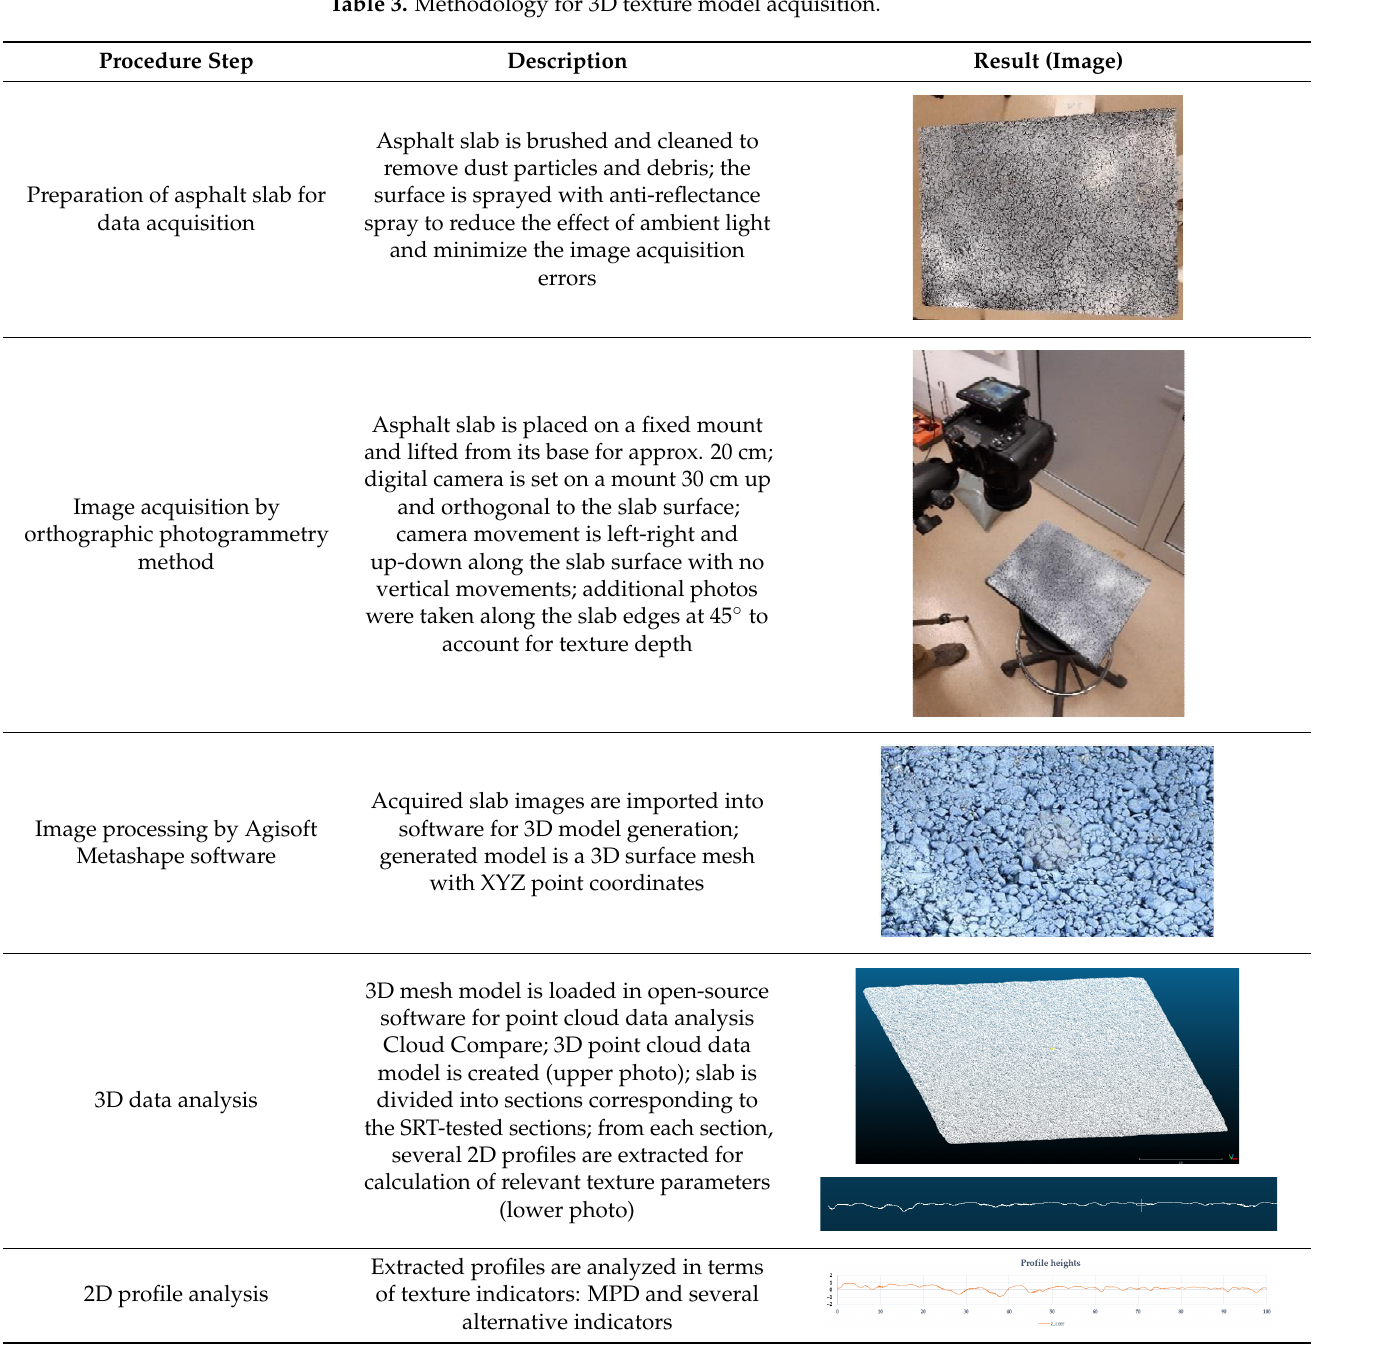
Table 3. Methodology for 3D texture model acquisition.